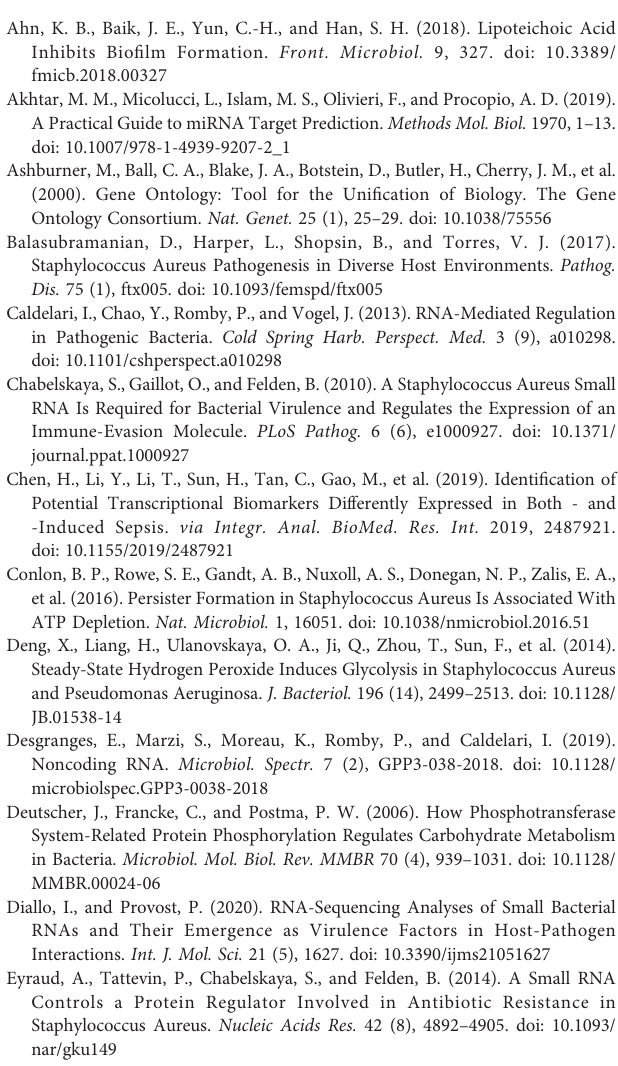
Supplementary Figure 4 | Bubble chart of metabolite speci fi c pathway enrichmentusingthecompoundsintheKEGGdatabase.Allpathwayswereclassi fi ed